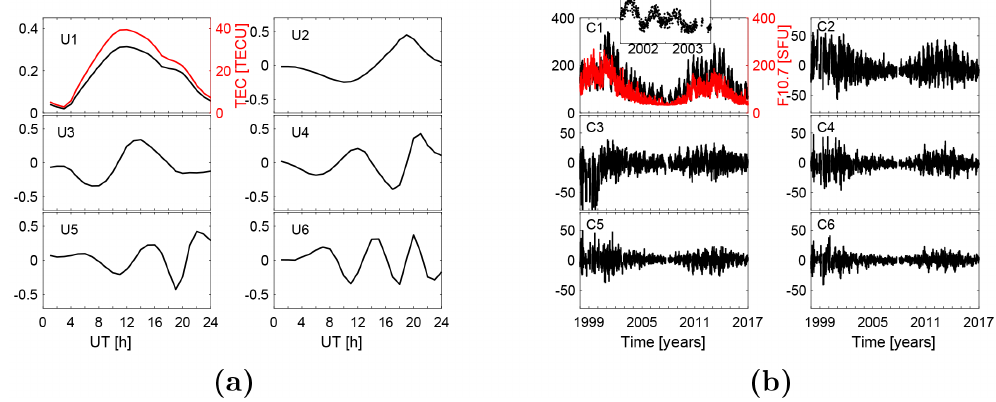
Figure 1. The first six basis functions (a) representing the diurnal variation and their coefficients (b) which show the long-term variation of TEC over MAL2. The red curves in the top left panels in (a) and (b) compare the diurnal mean TEC with the first basis vector U 1 and the solar radio flux index measured at 10.7cm wavelength (F10.7) with coefficients C 1 of the first EOF mode, respectively. Inserted at the top of the top left panel of (b) is a magnified section of the coefficients C 1 in 2002–2003 to show the semiannual and annual variations.